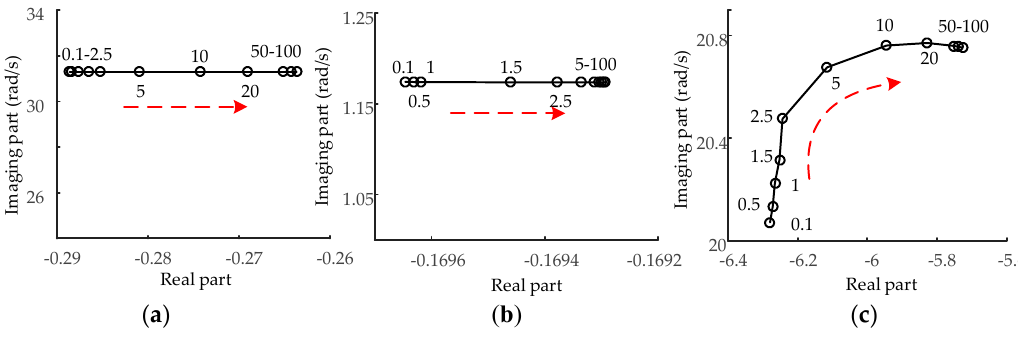
Figure 9. Impact of the current controller parameters: K R ( a ) Tor-1 mode ( b ) Tor-2 mode ( c ) Electro mode.